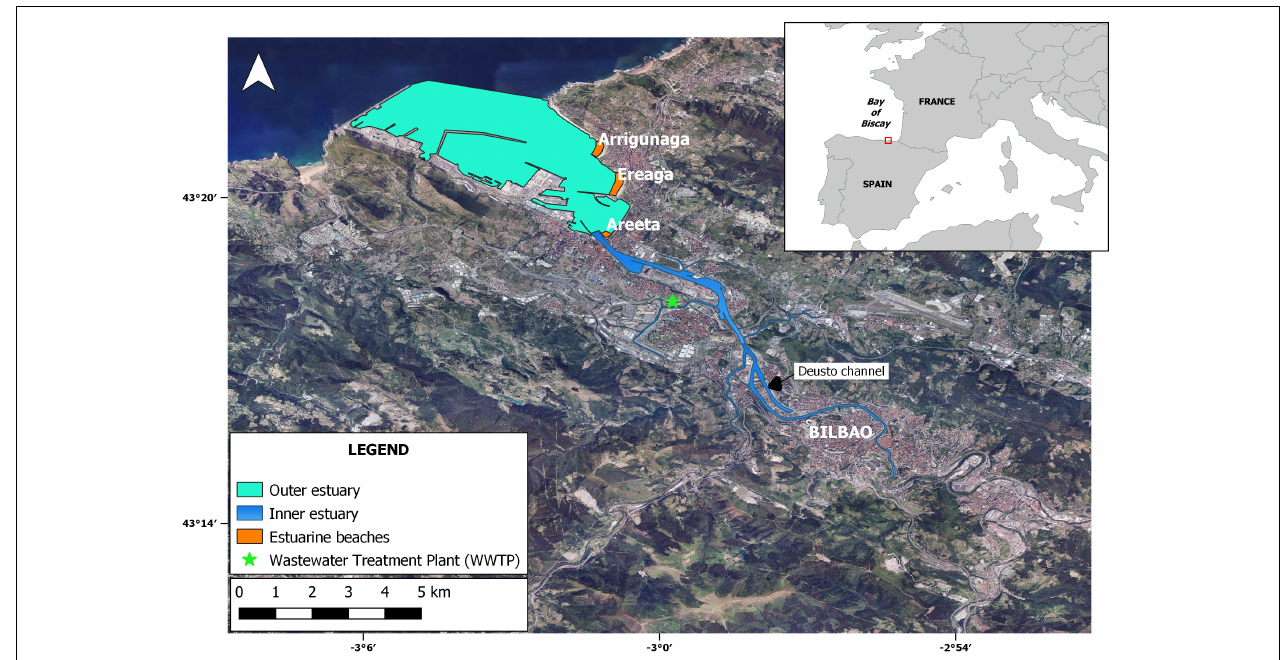
FIGURE 3 | Location of the Nerbioi estuary within the Bay of Biscay and location of the three estuarine beaches, the Wastewater Treatment Plant (WWTP) and the city of Bilbao.